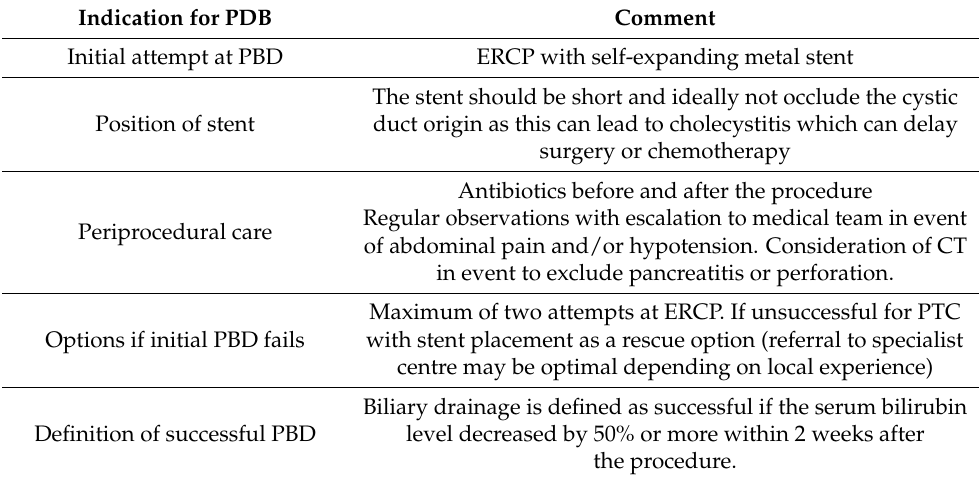
Table 2. Tips for optimising care in the event of PBD